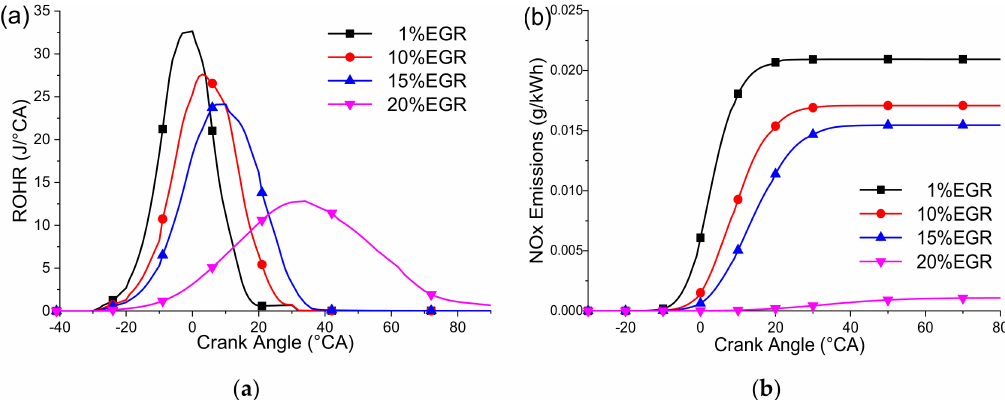
Figure 8. Rate of heat release (ROHR) and NOx emissions at di ff erent EGR ratios: ( a ) ROHR; ( b ) NOx